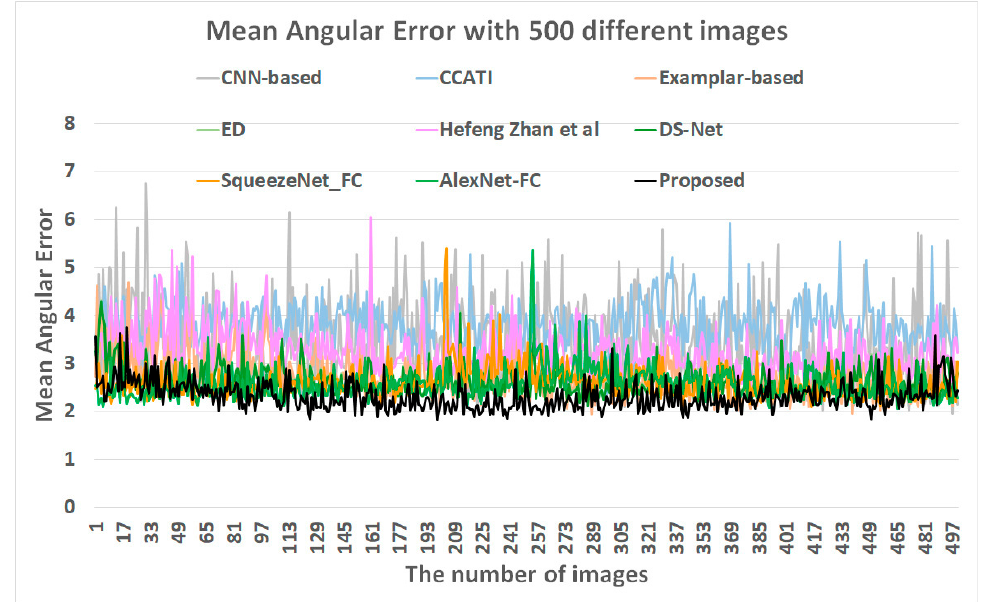
Figure 9. Comparison of the mean angular errors of 500 different gray-ball images.